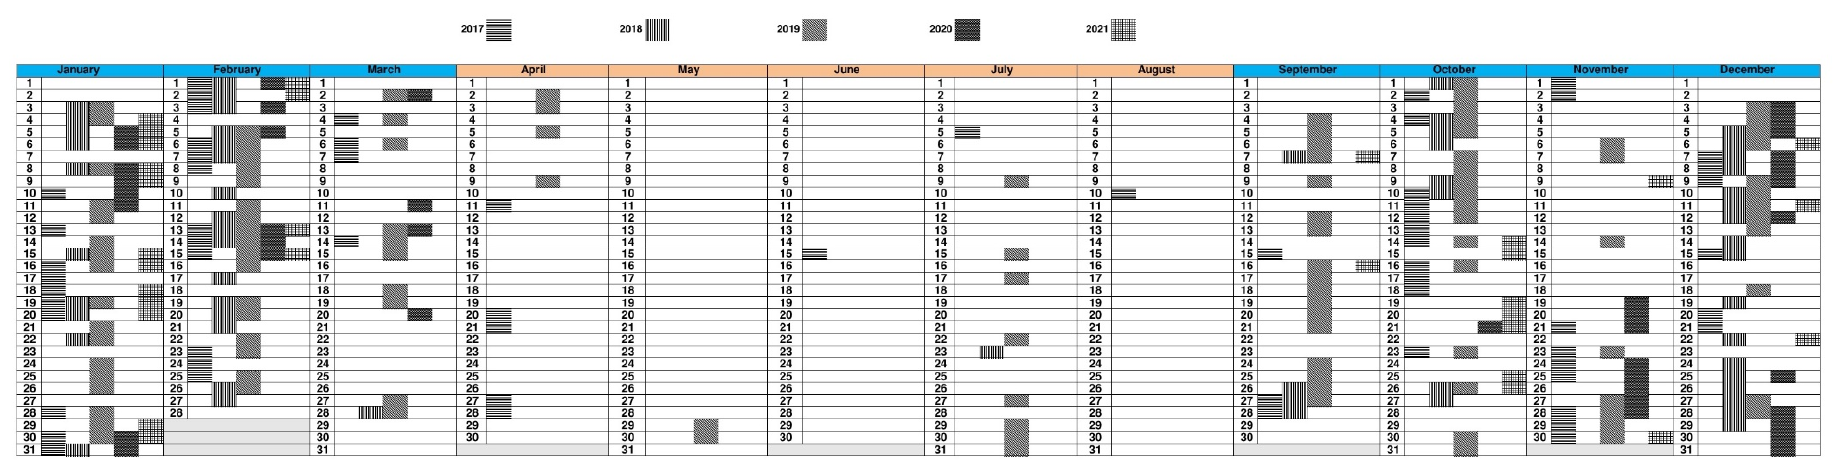
Figure 2. Results of the hierarchical clustering analysis.